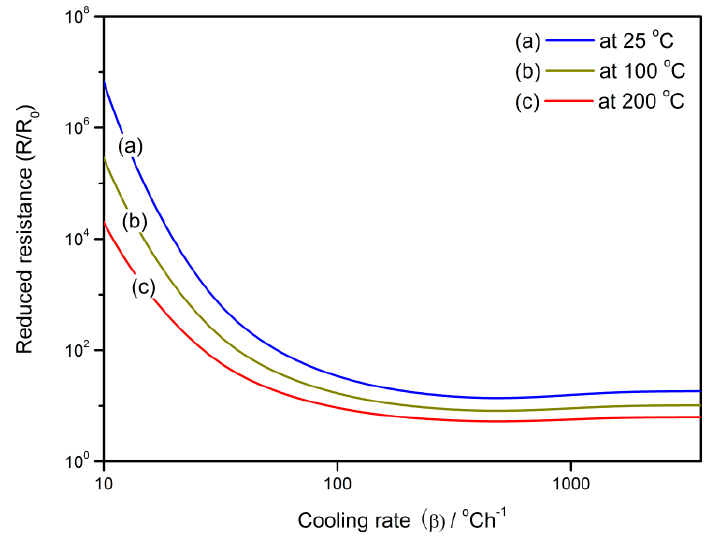
Figure 8. The relationship between reduced resistance ( R / R 0 ) of the gas sensor and the cooling rate at the operating temperatures of 25, 100, and 200 °C.